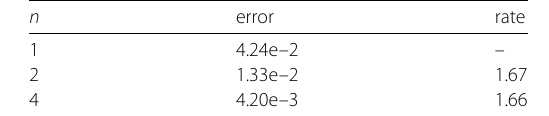
Table 3 Global error estimate and convergence rate with the same parameters as used in Fig. 1(c) n error rate